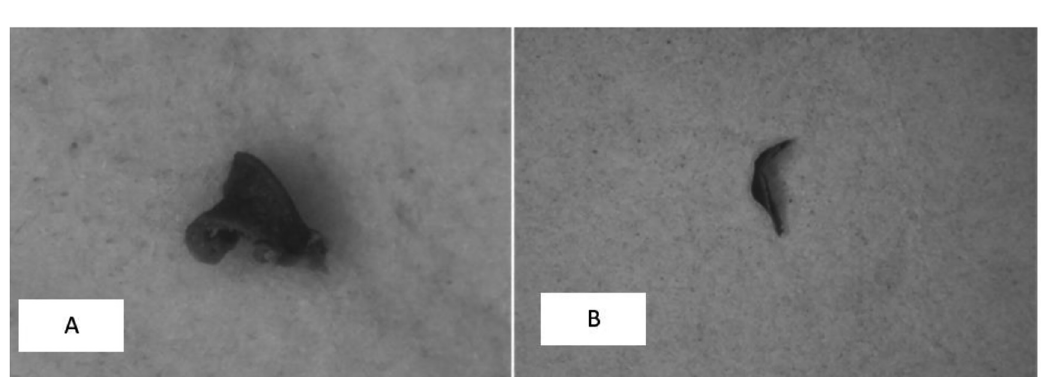
Figure 1: (Top, A) penetration method 1, angled needle entry fully through stopper diaphragm; (Top, B) penetration method 2, angled entry coupled with downward pressure until bevel fully enveloped by stopper;(Bottom)bevelpositionsrelativeto the stopper surface.